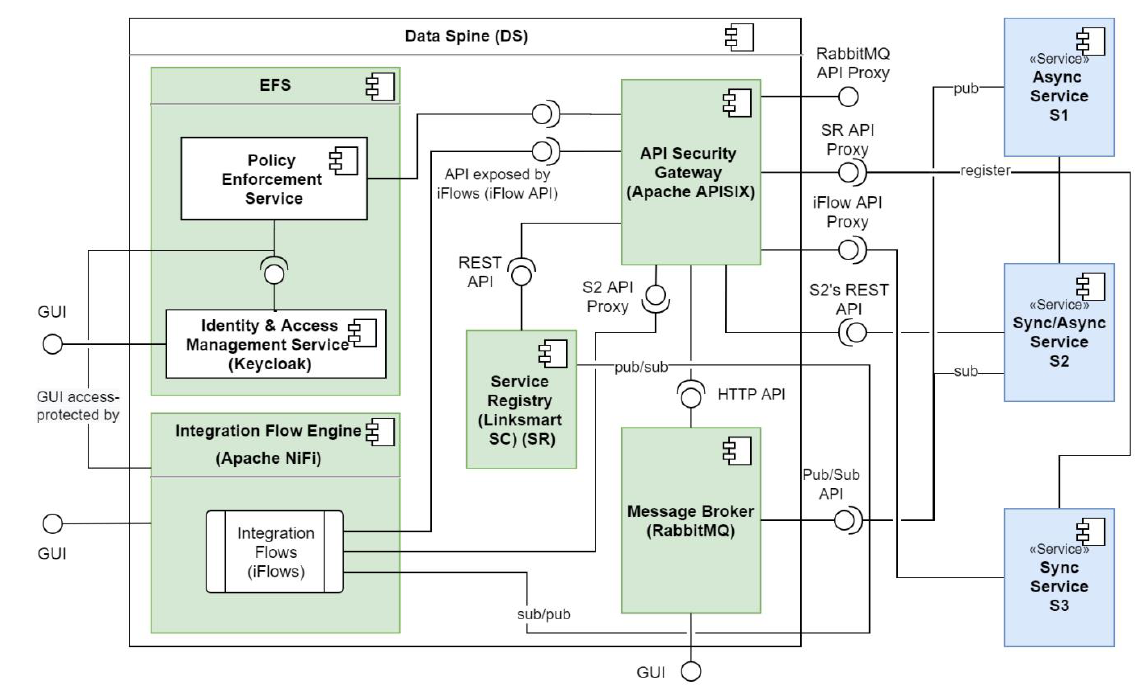
Figure 7. Reference implementation of the Data Spine.